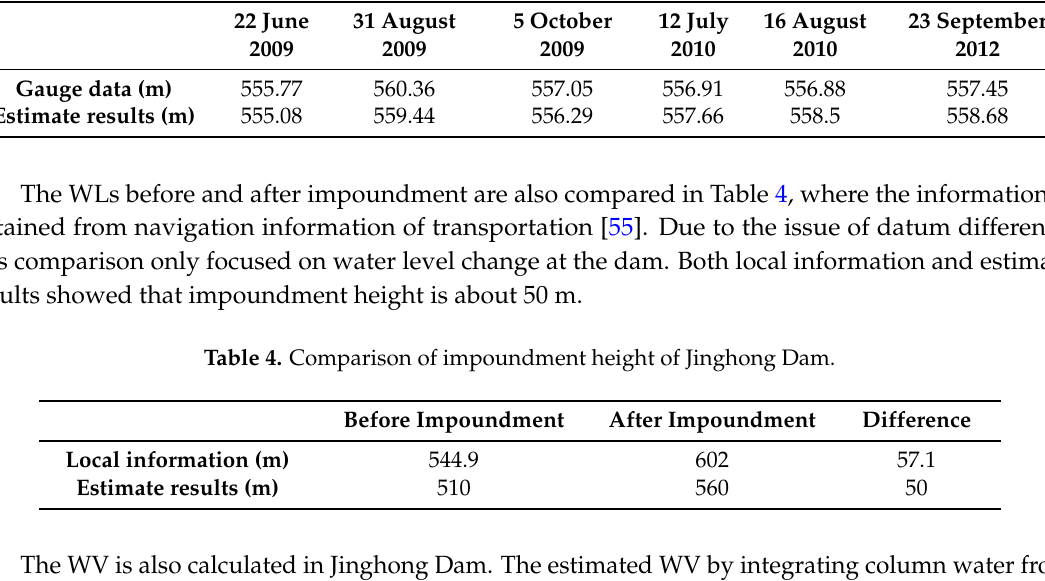
Table 3. Comparison between gauge data and estimated results of Jinghong Dam.